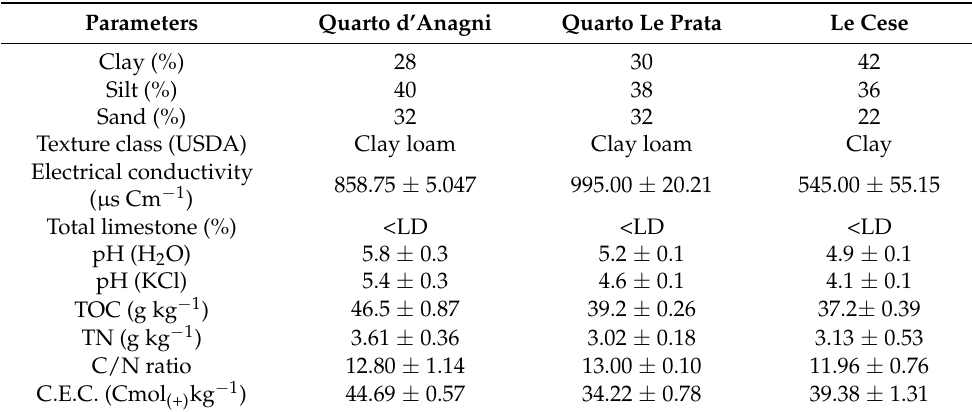
Table 1. Physical-chemical soil characteristics.